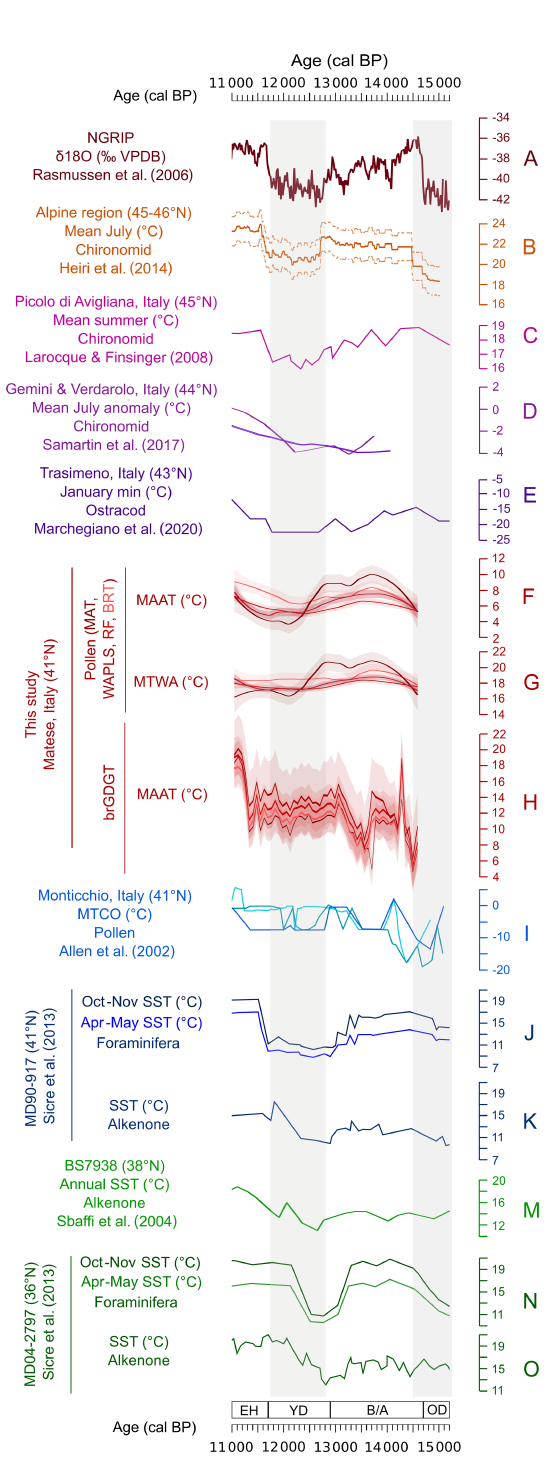
Figure 9. Synthesis of temperature records inferred from differ- ent proxies in Italy from 15000 to 11000calBP and comparison with the NGRIP ice core record. MAAT stands for mean annual air temperature. MTWA stands for mean temperature of the warmest month. MTCO stands for mean temperature of the coldest month. OD stands for Oldest Dryas. B/A stands for Bølling–Allerød. YD stands for Younger Dryas. EH stands for early Holocene.